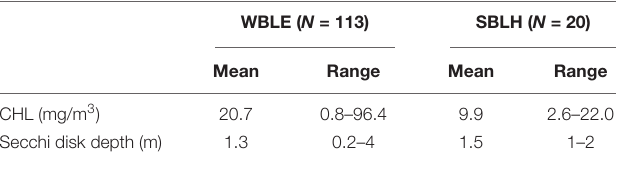
TABLE 2 | Summary statistics for the in situ chlorophyll- a (CHL) and Secchi disk depth measurements collected in western basin of Lake Erie (WBLE) and Saginaw Bay in Lake Huron (SBLH) during the 2020 field